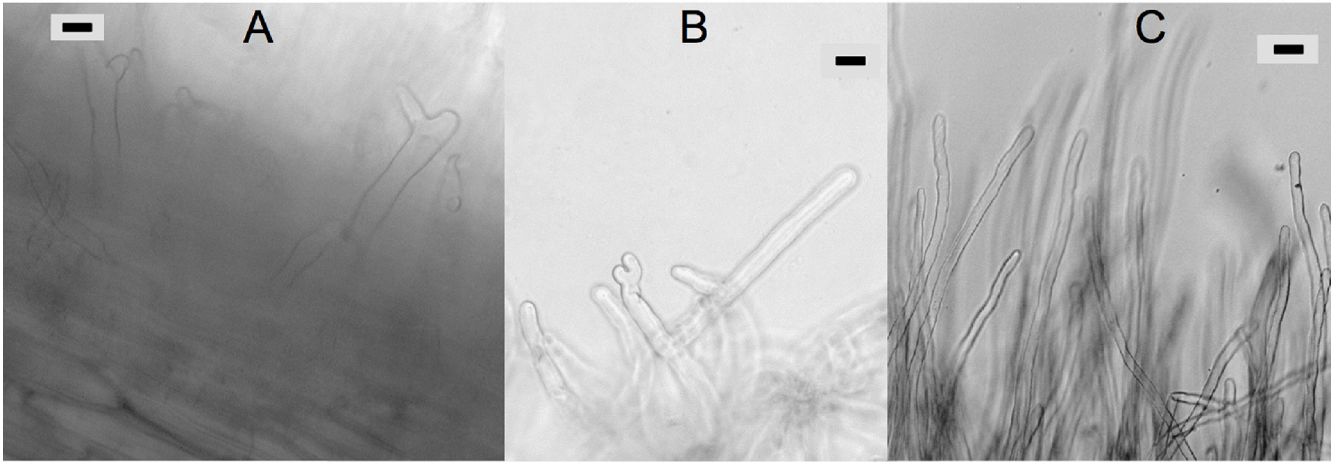
Fig 5. Analysis of the ability of Frankia Dg1 nodC ( nodC_Dg1 ) to complement a rhizobial nodC mutant. Roots of P . sativum show root hair deformation 31 days after inoculation with (A) R . leguminosarum A56 nodC ::Tn 5 mutant complemented by Frankia Dg1 nodC_Dg1 and after inoculation with (B) wild type R . leguminosarum A34. (C) Roots inoculated with the original R . leguminosarum A56 nodC ::Tn 5 mutant do not show root hair deformation. Root hair deformation was more pronounced after the infection with wild type rhizobium (B) or with the nodC ::Tn 5 mutant complemented by the homologous nodDnodABC operon (data not shown), than with the strain complemented by Frankia Dg1 nodC_Dg1 (A). Size bars indicate 10 μ